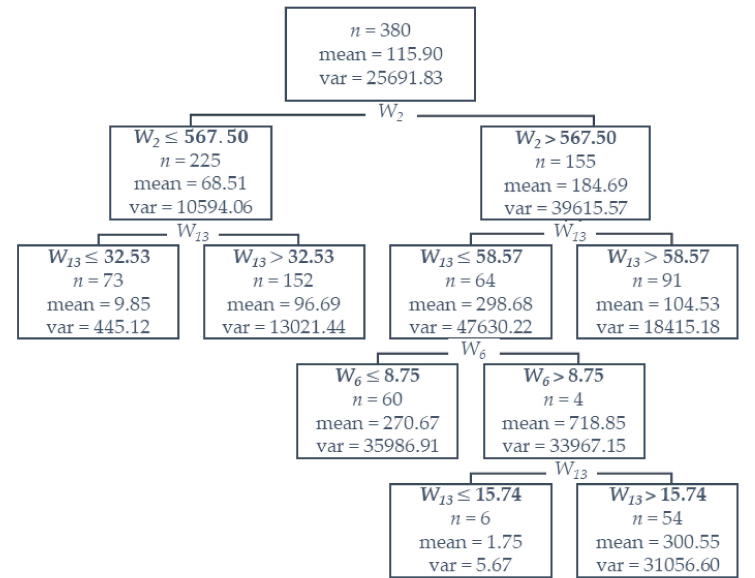
Figure 3. Regression tree for the indicator W 1 at the poviat level. Source: The authors’ calculations in Statistica 13 , based on data of: KOWR and